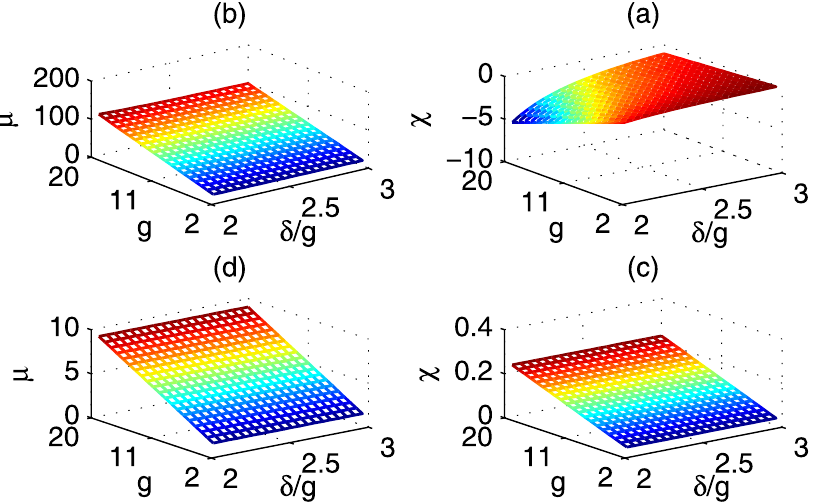
Figure 4. Two phase parameters μ and χ vias relative detuning δ / g and coupling strength g . ( a ) χ vias δ / g and g . ( b ) μ vias δ / g and g . Here, Δ 1 = 4 g , Δ 2 = 4 g + δ , ν = g , Ω = g . μ > 0 and χ < 0 are useful for generating negative phases. ( c ) χ vias δ / g and g . ( d ) μ vias δ / g and g . Here, Δ 1 = 9 g , Δ 2 = 9 g + δ , ν = 4 g , Ω = g 3 . Here, χ and μ are